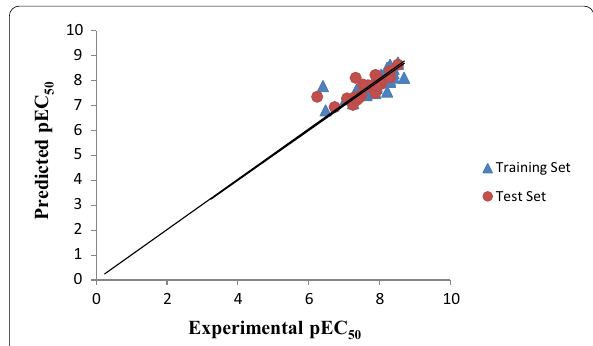
Fig. 3 Plot of the model predicted against experimental anti-hepatitis C bioactivity values